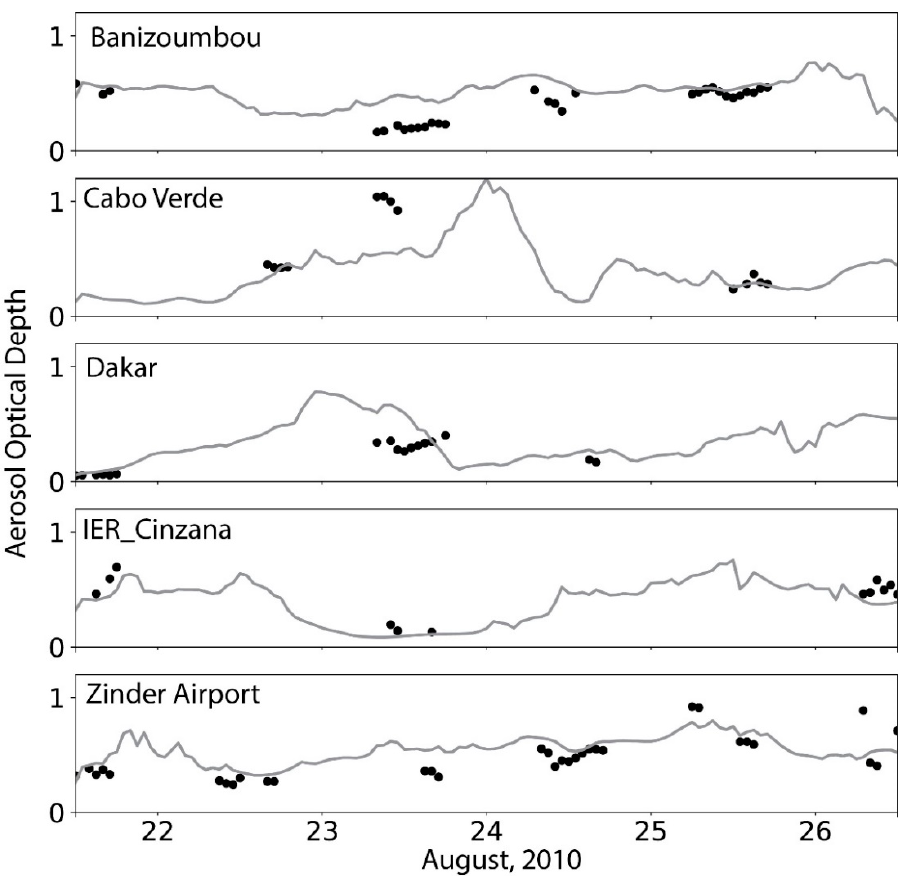
Figure 4. Aerosol optical depth (AOD) at 550 nm from five AERONET sites (dots) superimposed (lines) by the corresponding simulated AOD from experiment ExDO from 1200 UTC 21 to 0000 UTC 27 August 2010. The locations of these sites are shown in Figure 1b.